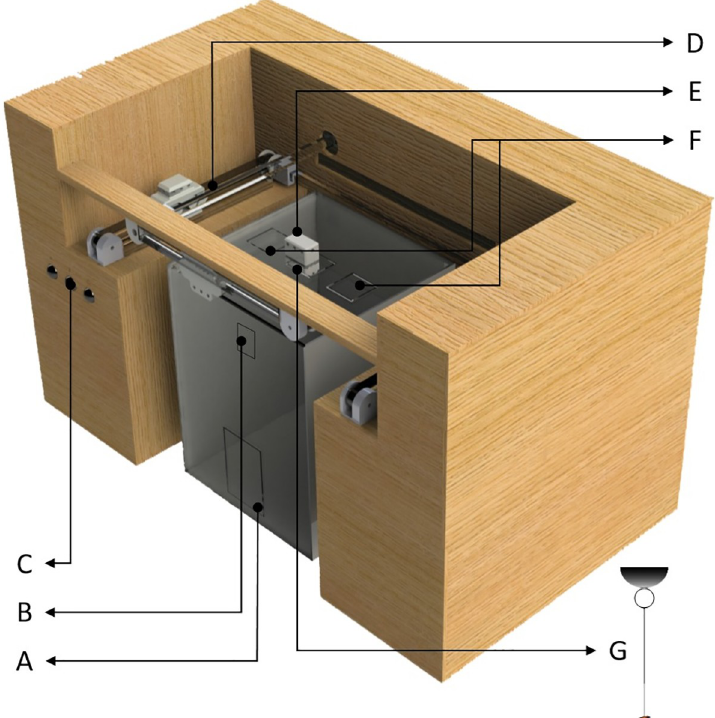
Fig 2. Components of the automated cage. Aperture for introducing the spider (A). Aperture for introducing live prey (B). Buttons controlling the moving lure (C). Motor mechanism consisting of 4 guide blocks, 4 rails and 2 means of movement that use two pairs of independent rails; each electric motor is connected by a toothed belt to a guide block, which in turn is connected to a busbar that moves the remaining guide block located in parallel; each pair of guide blocks located in parallel is connected to a moving part through a nylon thread, generating movement along an axis (D). Upper magnet (E). Aperture for introducing false prey (lure) (F). Lower magnet from which the lure is suspended by a transparent thread inside the acrylic box